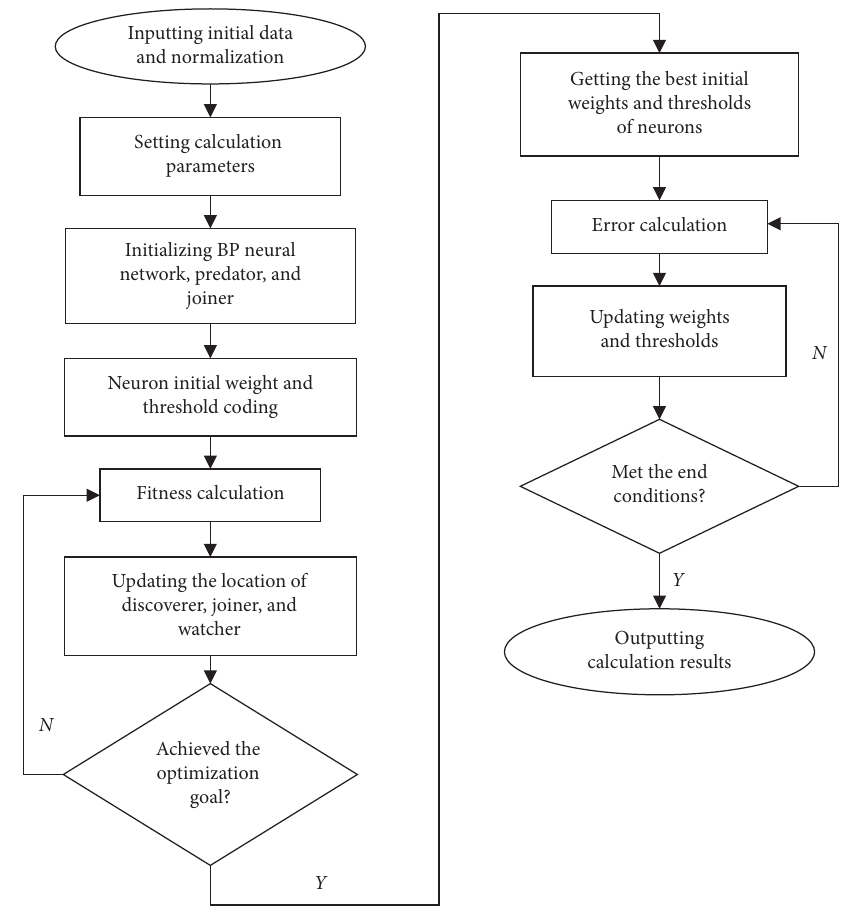
Figure 2: Flow chart of the SSA-BP model.